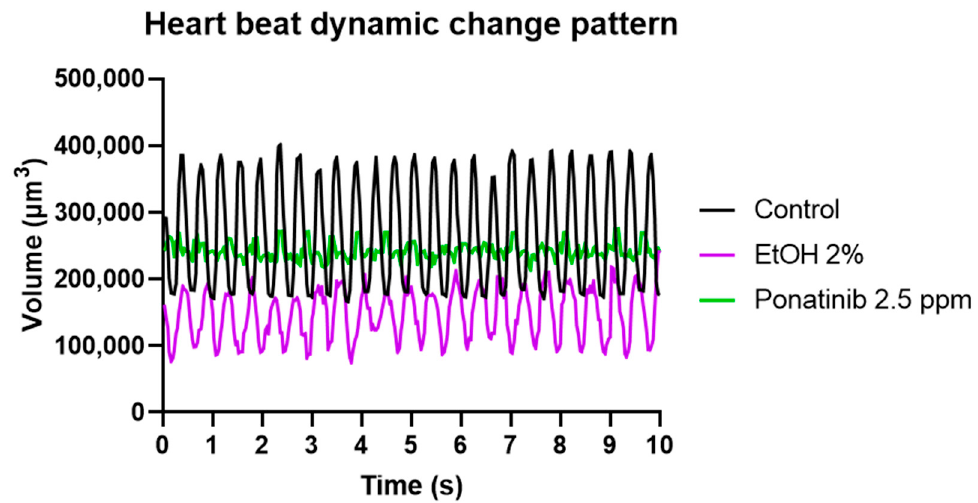
Figure A2. The volume-change peaks (black color), short axis (blue color), and long axis (red color) of heart movement generated during diastolic and systolic phases for 10 s.